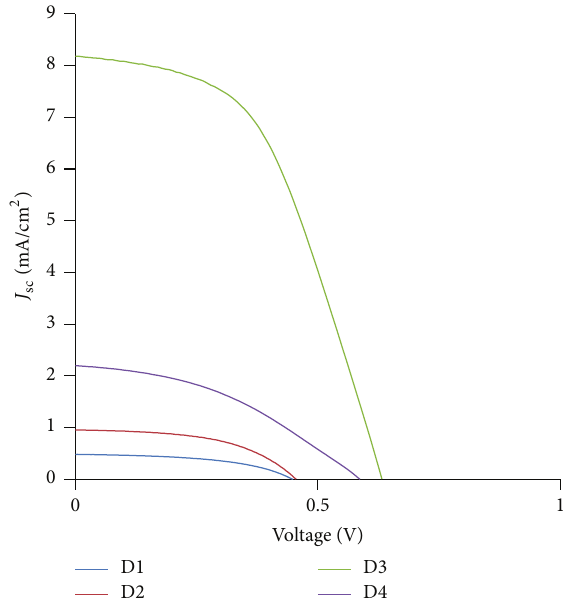
Figure 4: Current-voltage curves of DSSCs.